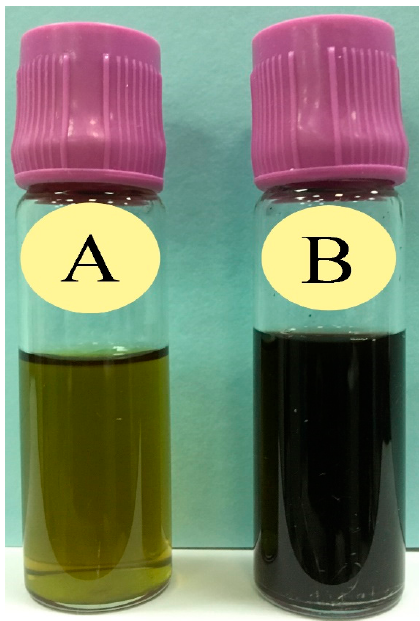
Figure 1. Confirmation of gold nanoparticles (AuNPs) synthesis through the change in color: ( A ) Prior to the addition of HAuCl4·3H2O in Ricinus communis leaf ethanol extract (RcExt) and ( B ) after the addition of HAuCl 4 ·3H 2 O to RcExt.